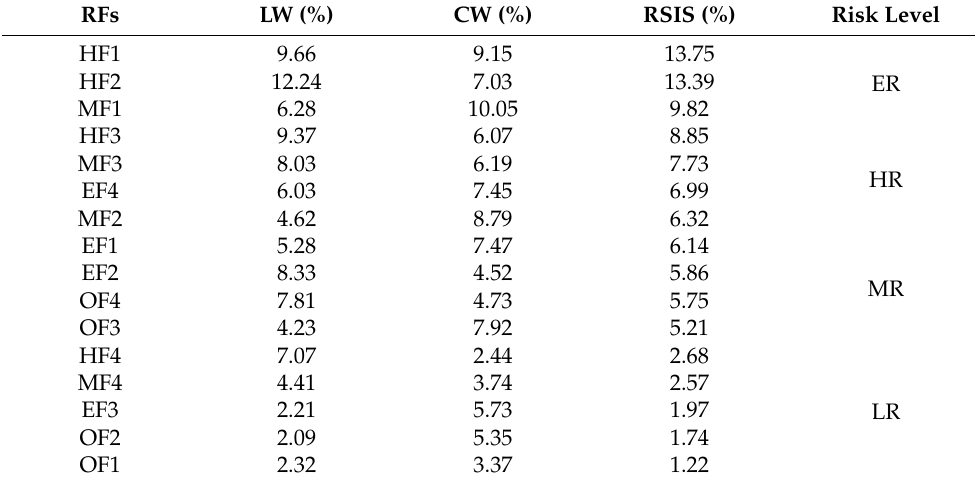
Table 6. The classification of